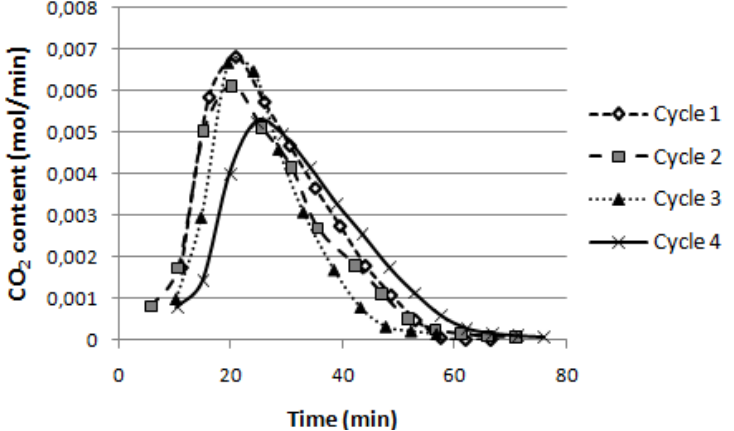
content within the N Figure 7. CO 2 calcinations